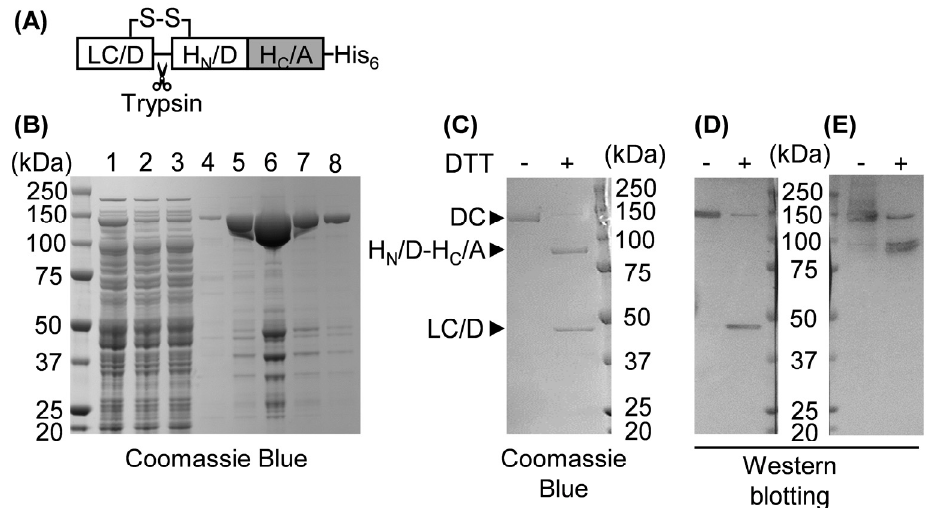
Figure 4. Design, purification, and characterisation of recombinant chimera DA. ( A ) Schematic of chimera DA created by recombinantly fusing LC/D and H N /D regions (white boxes) to H C /A (grey box); note that a C-terminal polyhistidine tag (His 6 ) was added to allow affinity purification. S-S denotes an interchain disulphide; scissors indicate an exposed loop labile to cleavage by trypsin. ( B ) SDS-PAGE gel stained with Coomassie blue dye showing the purification of SC chimera DA from E. coli lysate by IMAC. Lanes: 1, cleared cell lysate; 2, flow-through from the Talon ® resin; 3, effluent after addition of washing buffer containing 5 mM imidazole; 4–8, fractions eluted with 500 mM imidazole. A ladder of protein standards was run in the first (non-numbered) lane and numbers to the left of each band indicate the molecular size of individual standards in kDa. ( C – E ) After conversion from SC to DC using Trypzean ® (see Section 4), the DA sample was subjected to SDS-PAGE in the absence or presence of 50 mM DTT (as indicated), followed by Coomassie Blue staining ( C ) or Western blotting ( D , E ) with antibodies recognising LC/D ( D ) or BoNT/A ( E ); protein ladders used in ( C – E ) were the same as in ( B ).